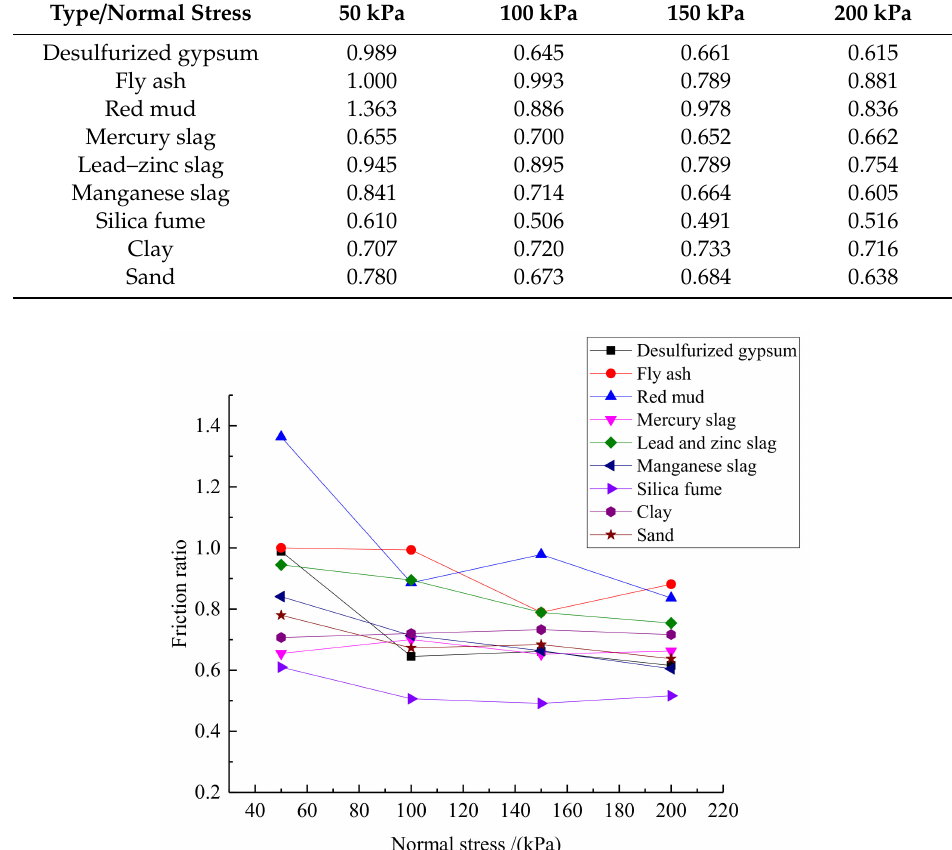
Table 3. Friction ratio for each solid waste or soil sample for di ff erent normal stresses.